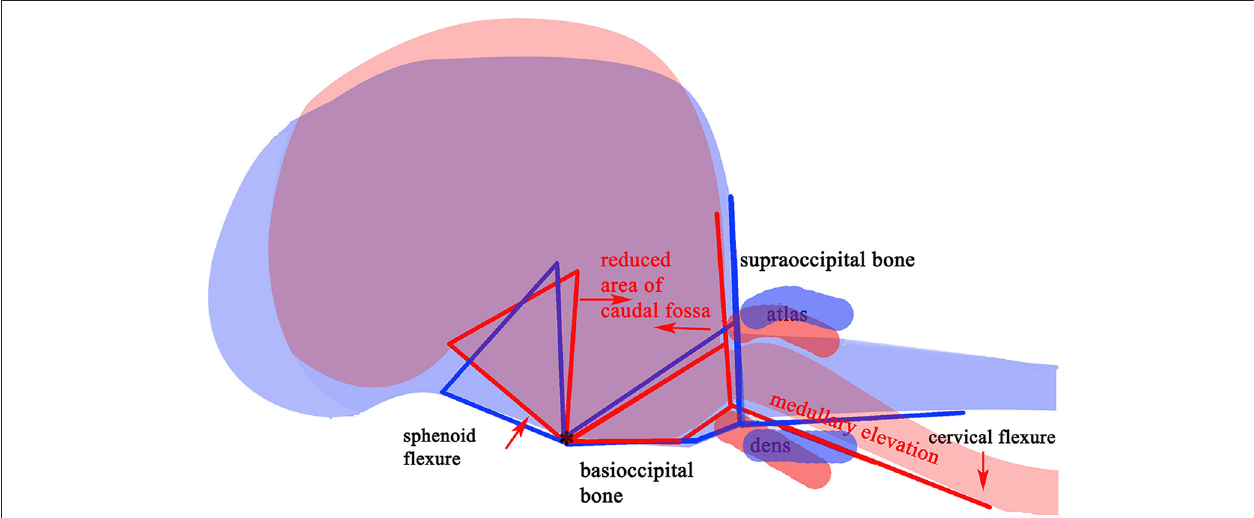
FIGURE 2 | Schematic framework of selected CM traits (red lines) and “normal” traits (blue lines) to illustrate underlying anatomical differences in the caudal cranium and cranial cervical vertebrae. The red (SM affected) lines are superimposed on those for representing normal (blue) and aligned along the skull base at fixed point “*”, the dorsum of spheno-occipital synchondrosis. The basisphenoid, possibly the presphenoid, is flexed dorso-caudally (“sphenoid flexure”). The cranial cervical vertebrae are more rostral, with the odontoid process, angled ventrally with medullary elevation (“cervical flexure”).